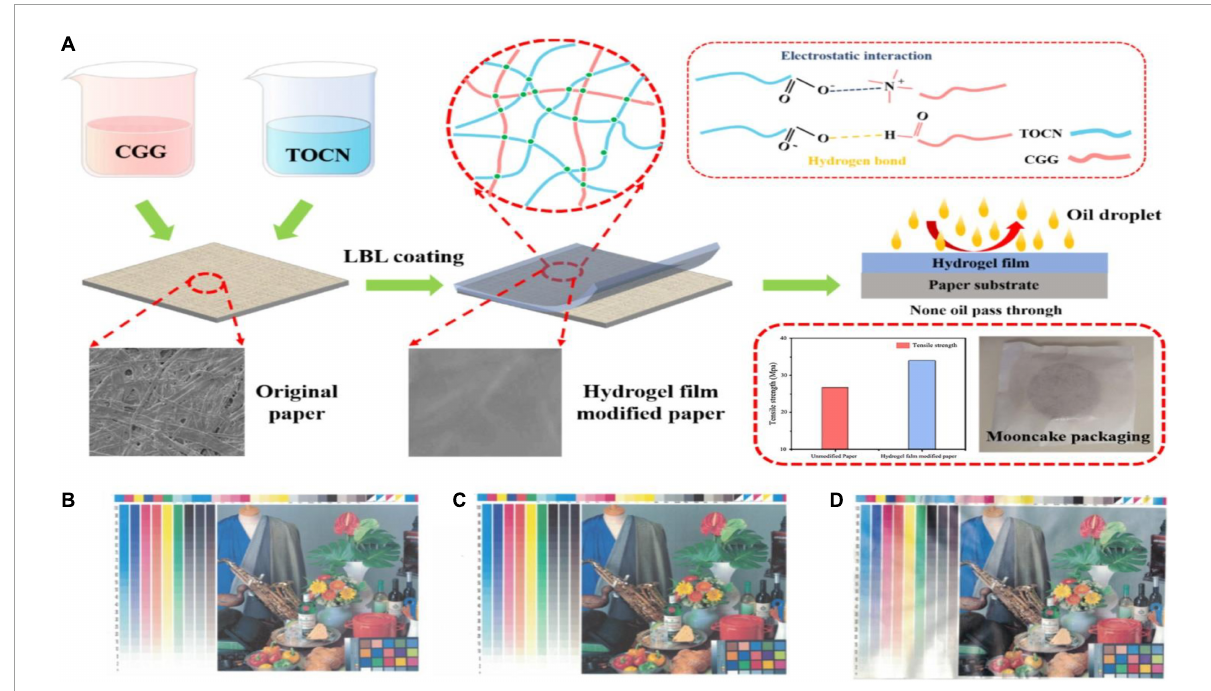
FIGURE3 (A) Schematic illustration of the 2,2,6,6-tetramethylpiperidine-1-oxyl (TEMPO)-oxidized cellulose nanofiber/cationic guar gum (TOCN/CGG) self-assembled hydrogel film modified paper for food packaging. Inkjet printing effects on (B) ordinary printing paper, (C) unmodified paper, and (D) 4-layer hydrogel film modified paper. Reprinted from Dai et al. (2021) with permission from